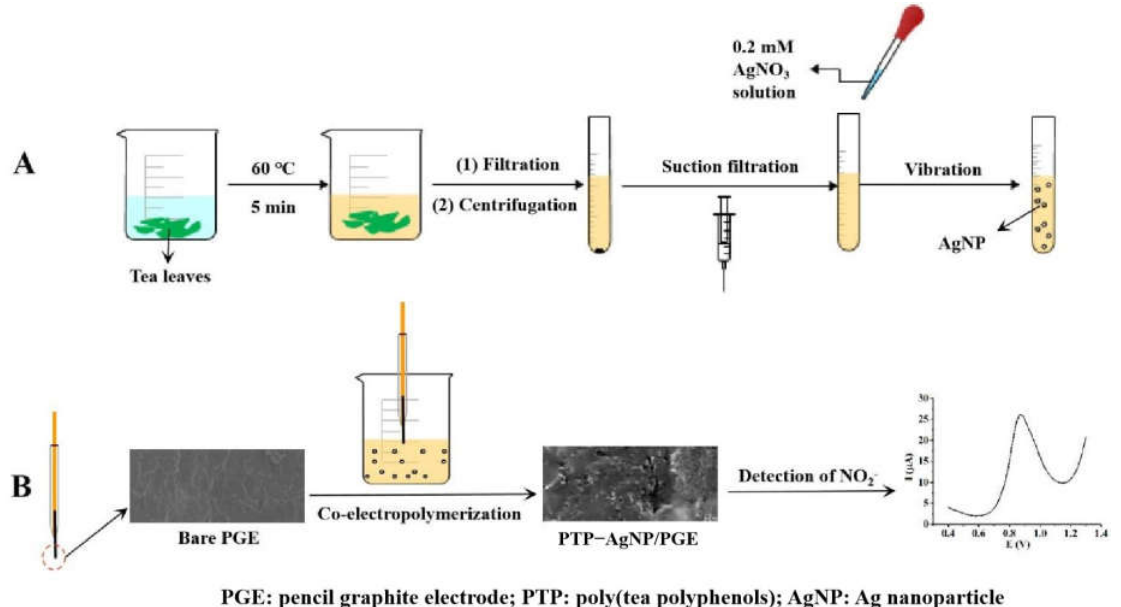
Figure 1. Diagram of the green synthesis processes of AgNPs with tea extract ( A ) and the fabrication procedures of PTP−AgNP/PGE ( B ).